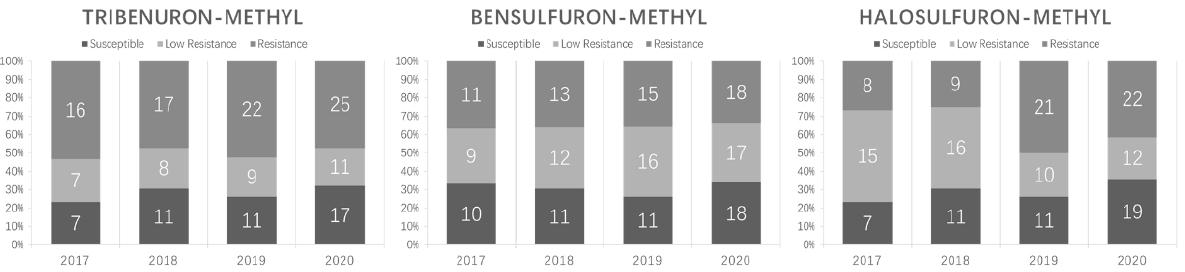
Figure 1. Distribution of cleavers seeds classified as susceptible (<2% survival), having low resistance (2% to 19% survival) and resistant (>20% survival) to a discriminating rate for tribenuron-methyl, bensulfuron-methyl and halosulfuron-methyl over the 4-year survey (2017 to 2020).